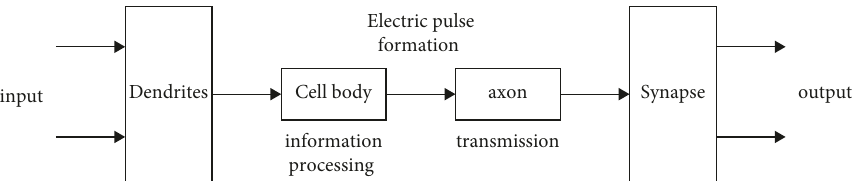
Figure 5: Single neuron structure